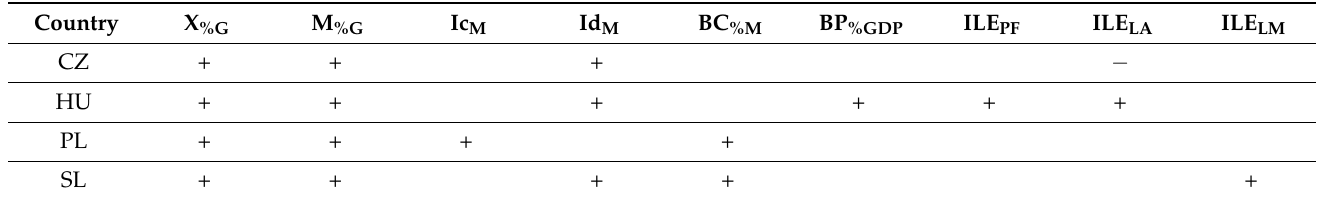
Table 12. Influences of indicators (positive or negative) from regression equations on FDI